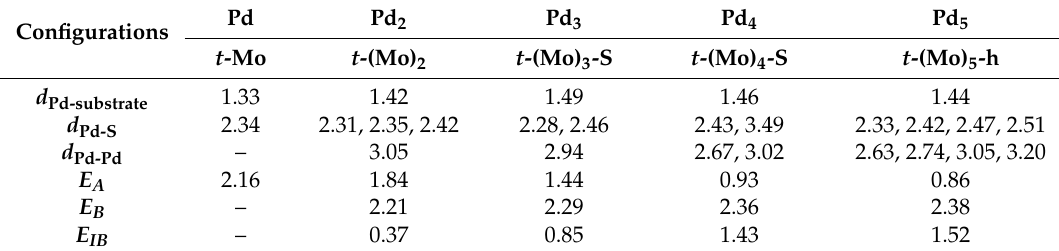
parameters and energies are Å and eV,